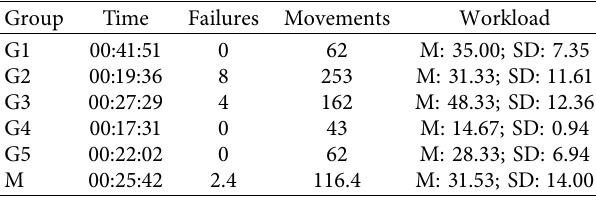
Table 2: Results on the joint problem-solving